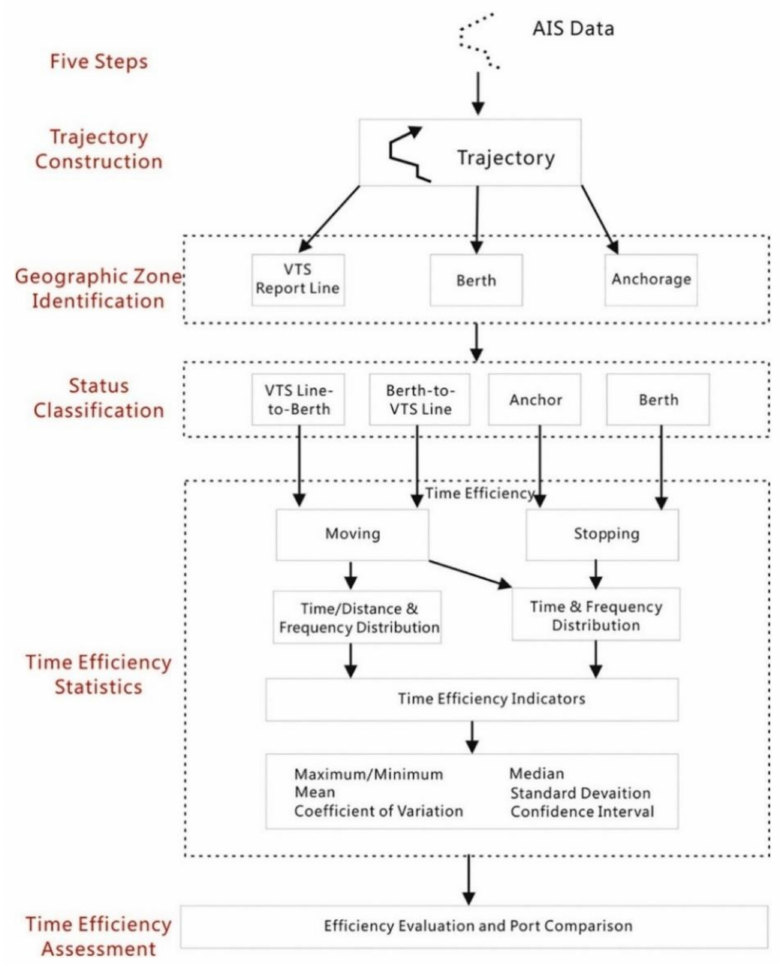
Figure 7. AIS-based time efficiency assessment framework